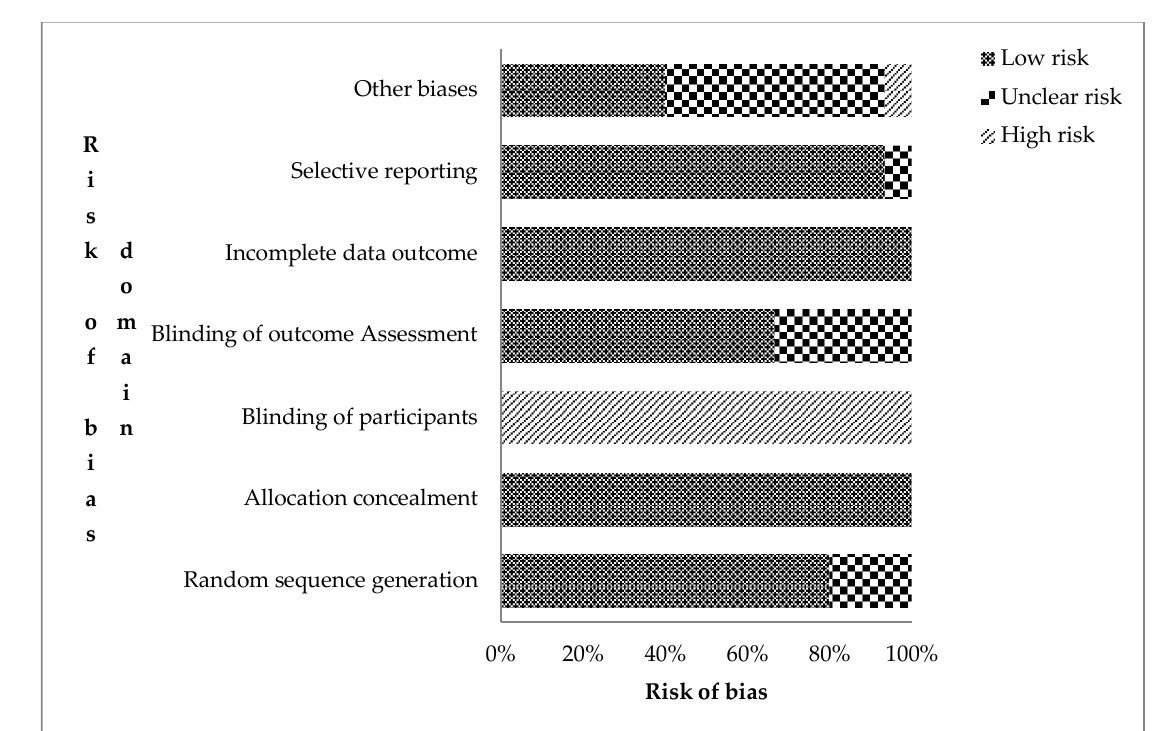
Figure 2. Risk assessment bias for the included cRCTs ( n = 14) on the effect of sanitation on health outcomes in low- and middle-income countries (Authors’ judgement).